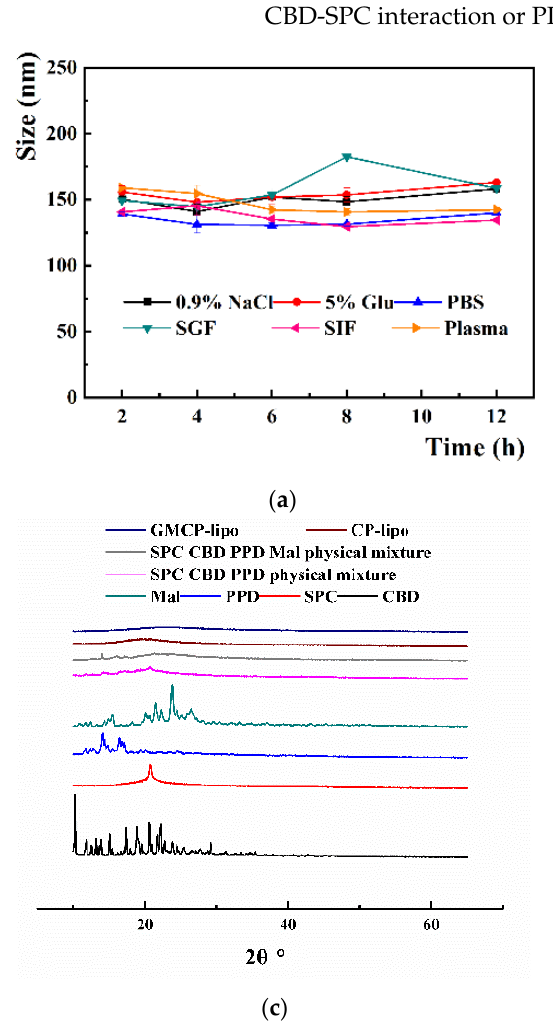
Both CP-liposome and GMCP-liposome are quite stable in various physiological me- dia. During the 12 h of incubation at 37 °C, the particle size (Figure 4a,b) and PDI values (Figure S2a,b) of the CP-liposome and GMCP-liposome were nearly unchanged in normal saline, 5% glucose solution, PBS (pH = 7.4), simulated gastric fluid (SGF), simulated intes- tinal fluid (SIF) and plasma, and no aggregation was observed, indicating good suitability for intravenous injection and oral administration.